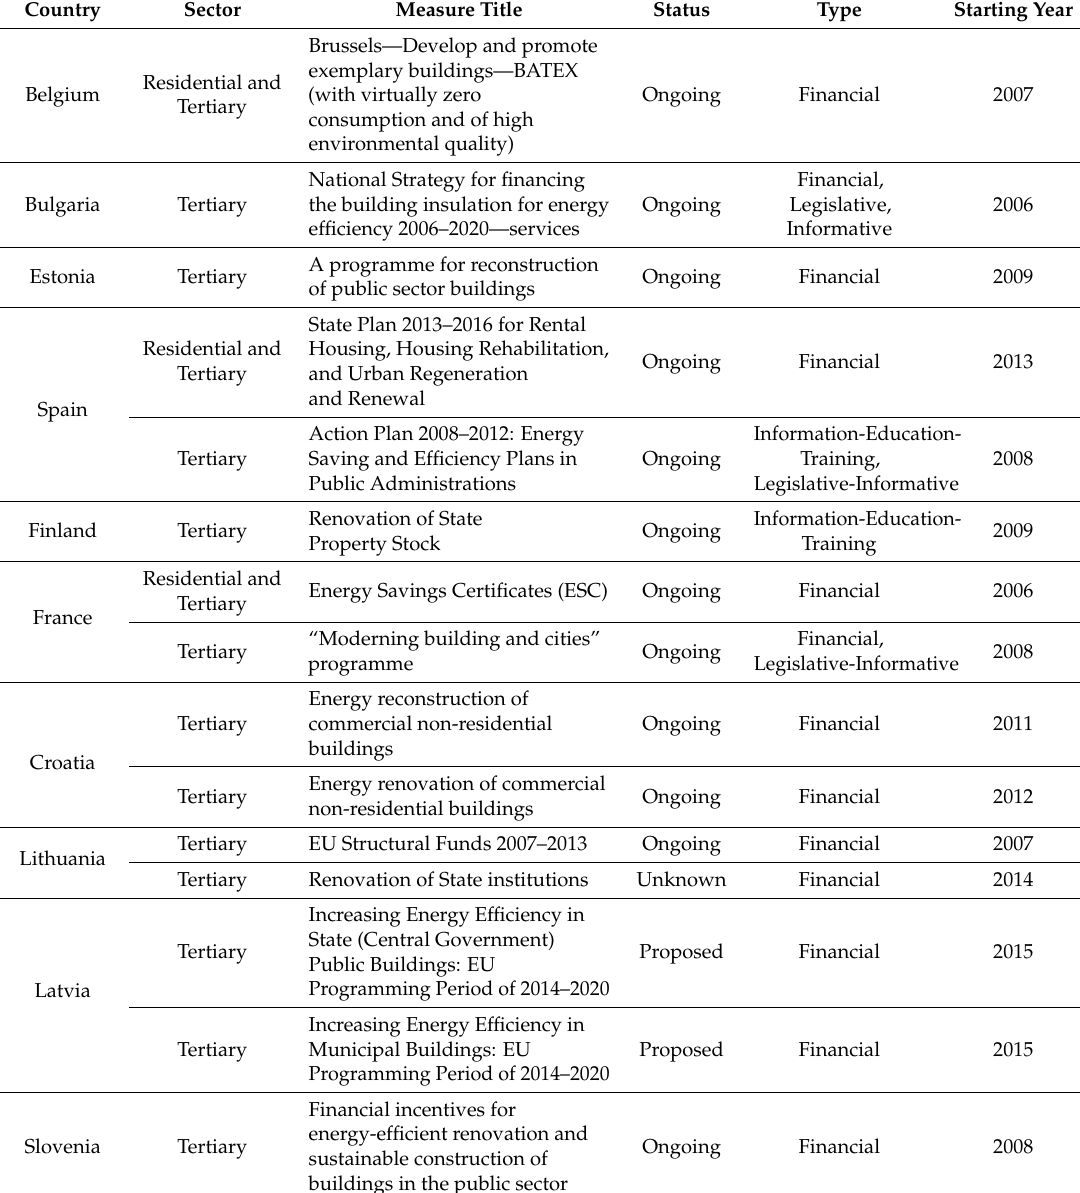
Table 3. Ongoing and proposed policy measures on non-residential building renovation with medium or high impact, extracted from the Odysee-Mure database